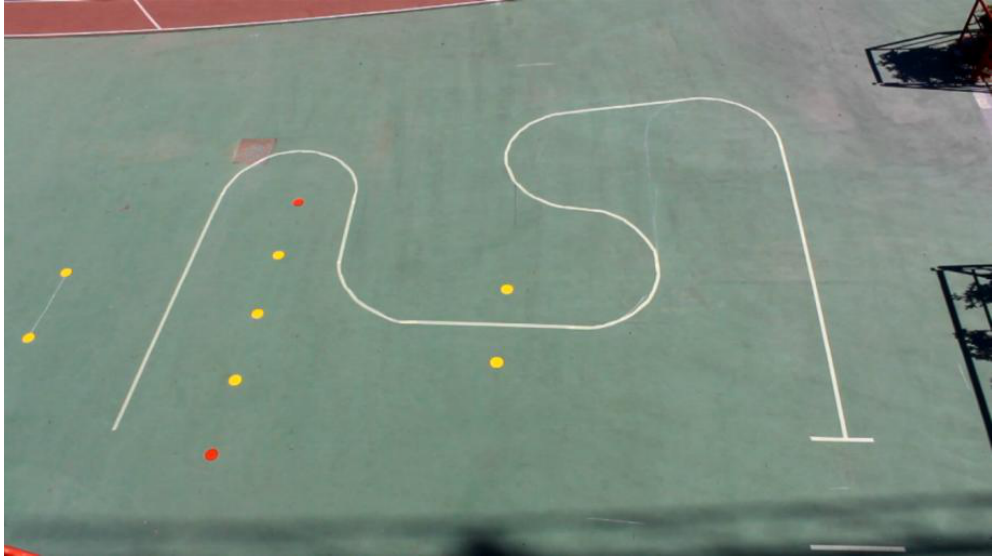
Figure 19. Path used to carry out the tests.